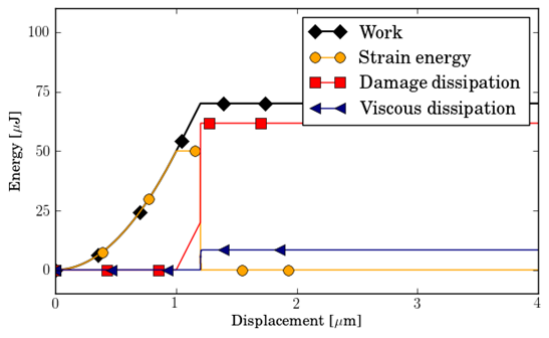
Fig. 7 Evolution of energies in function of displacement for unit element model using Hillerborg failure model with G Ic = 10 J/m 2